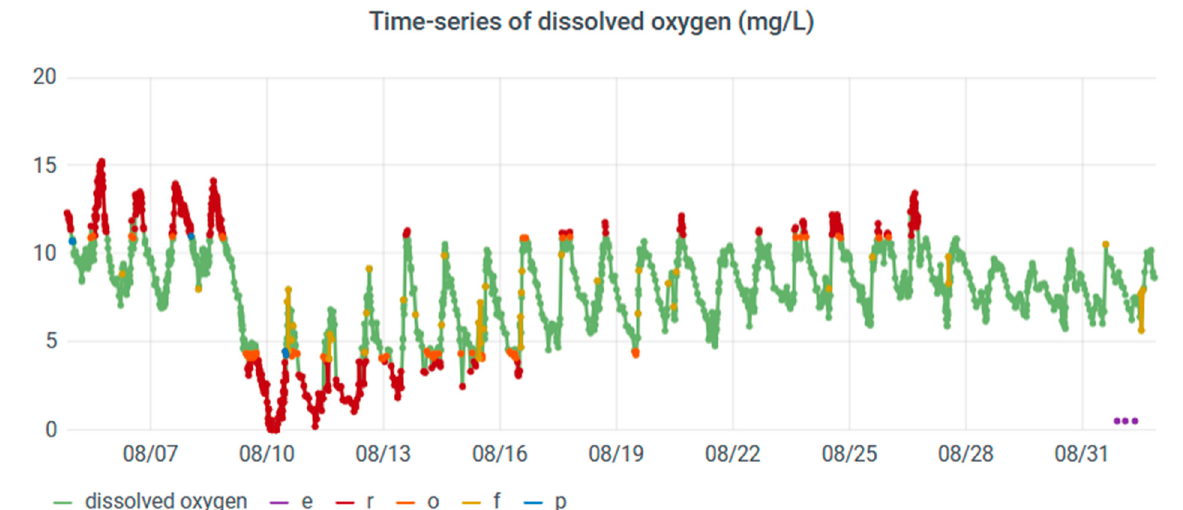
Figure 9. Graph showing the fluctuations of water dissolved oxygen (DO) over time with flagged data based on the quality checks of range, extreme value, extreme difference value and stack value tests, as shown in the HCMR online platform. Symbols: “e” for empty values, “r” for out-of-range values, “o” for outliers (the 5% highest and lowest values of the time-series), “f” for high and low fluctuations (5% of highest and lowest changes of consecutive values) and “p” for persistent values (no change of the parameter value for at least 48 hourly measurements).